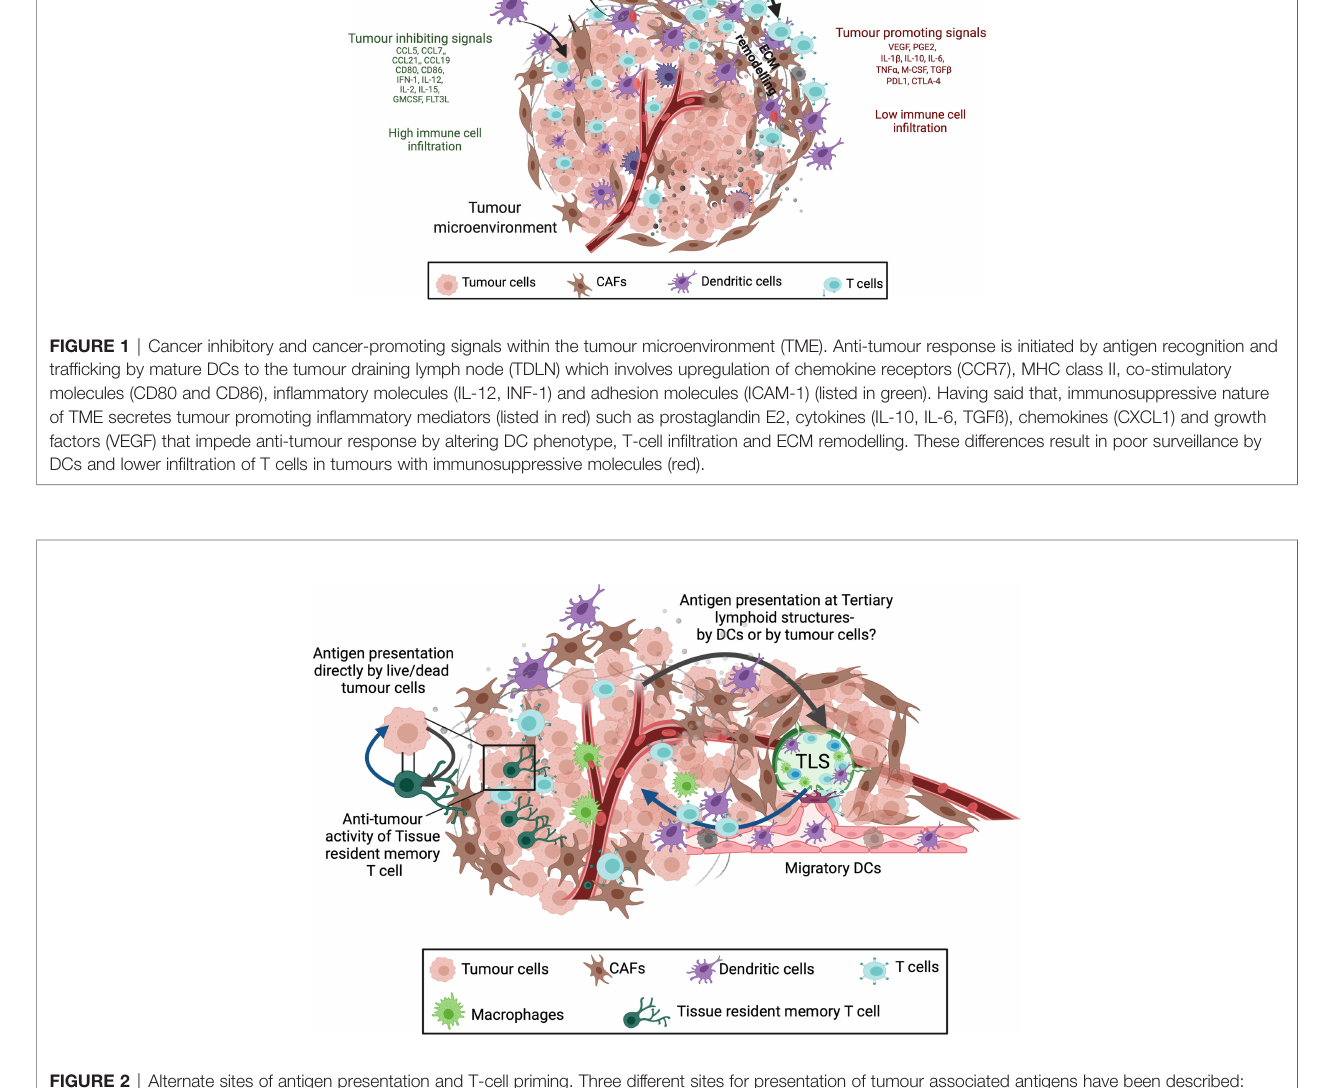
FIGURE 2 | Alternate sites of antigen presentation and T-cell priming. Three different sites for presentation of tumour associated antigens have been described: Tumour draining lymph node (TDLN), Tertiary lymphoid structures (TLS) and Tissue resident memory T cells. A population of memory precursor cells are believed to differentiate into CD103+ tissue resident memory T cells. These cells reside in the tumour and can recognize tumour antigens followed by killing the target tumour cell. In addition, tertiary lymphoid structures (TLS) also present a potential site for T cell priming. TLSs are organised cell aggregates formed within or at tumour margins in response to local in fl ammation and numerous cell-cell interactions occurring within the TME. Since these contain various immune cell types, TLSs can activate local immune response against the tumour, however the mechanism for T-cell priming within the TLSs is